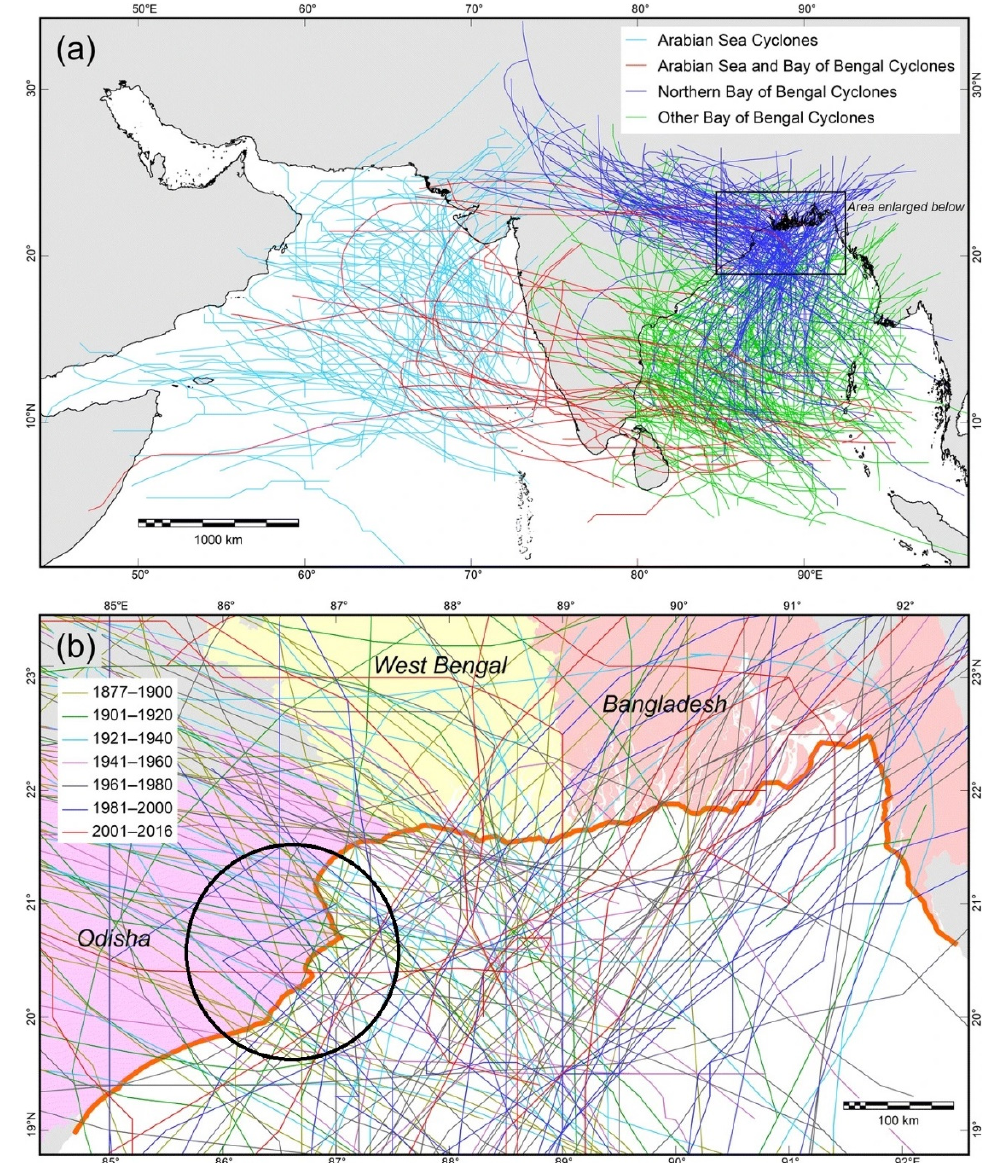
Figure 8. Storm and landfall analysis in the northern Bay of Bengal from 1877 to 2016 based on storm track data from IBTrACS and IMD; ( a ) Cyclone landfall in Northern Indian Ocean basin and ( b ) landfalling in Northern Bay of Bengal basin including Odisha, West Bengal and Bangladesh coasts. (Adapted from Spatiotemporal Analysis of Tropical Cyclone Landfalls in Northern Bay of Bengal, India, and Bangladesh by Bandyopadhyay et al., 2021 p.802 [59]). Black circle indicates the case study location.